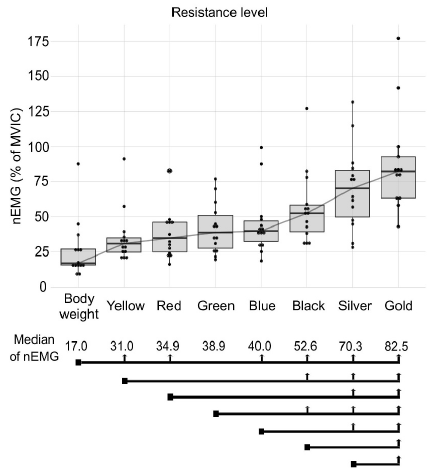
Figure 4. Median muscle activation (Median of nEMG) of the VL muscle for the different conditions: body weight, yellow, red, green, blue, black, silver and gold elastic band. The square point at the beginning of the black line marks the compared condition and the vertical arrows show significant differences between conditions. Finally, Figure 5 shows the averaged quadriceps muscle nEMG. The body weight condition had a median nEMG of 14.5%, this being significantly lower than all the other conditions. For the yellow and red band conditions, a two-level increase in elastic resistance did not increase nEMG. For the green, blue and black band conditions, a one-level increment in elastic resistance did not increase nEMG. Finally, the gold band condition provided a greater averaged nEMG (74.8%) than the other conditions.